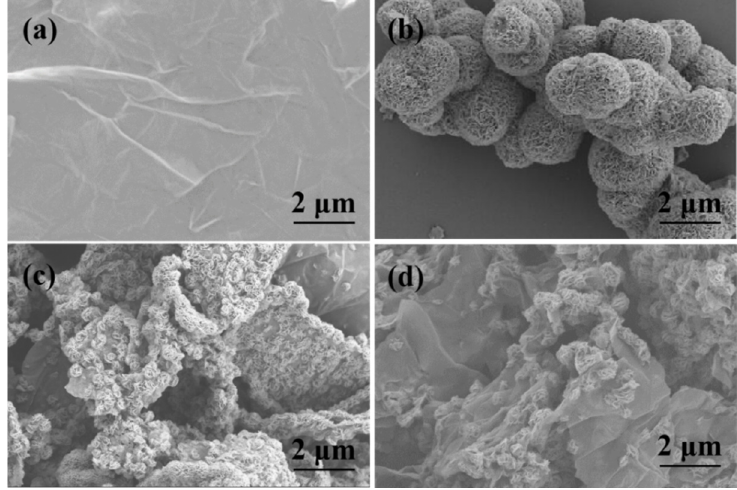
Figure 3. SEM images of ( a ) GO, ( b ) MoS 2 , ( c ) MoS 2 /rGO and ( d ) MoS 2 /rGO/GQDs.